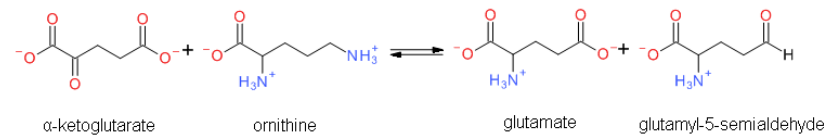
Figure 2. Overview of the reaction catalyzed by OAT.